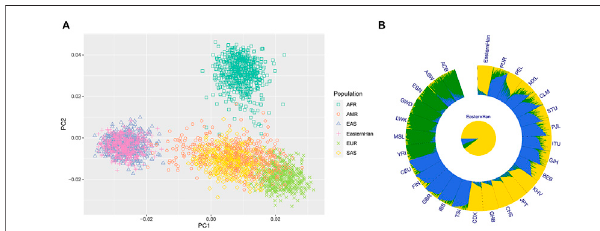
FIGURE 6 | Ancestry component analyses of the studied Eastern Han populations in comparisons with other continental populations. (A) PCA of Eastern Han and continental populations at PC1 and PC2. (B) Population geneticstructureanalysesofEasternHanandcontinentalpopulationsat K (cid:1)